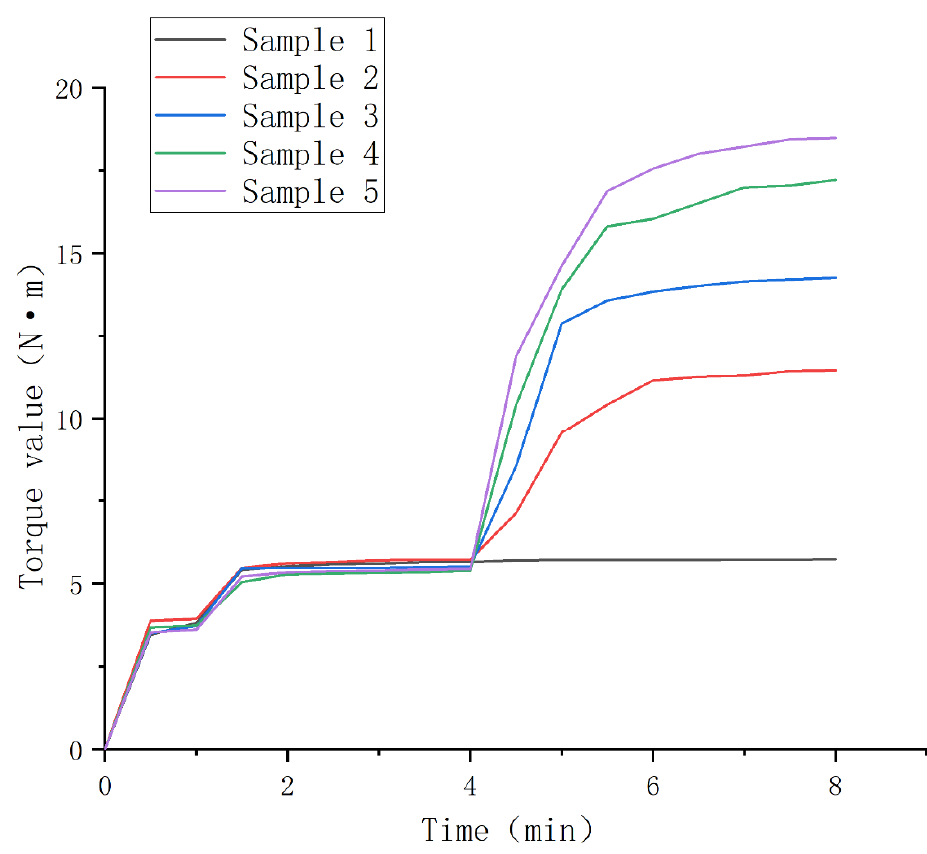
Figure 3. Torque value change diagram of samples 1–5 during vulcanization.